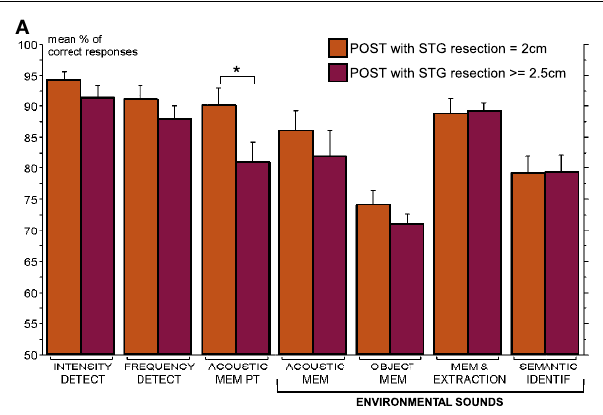
fractionated into two sub-groups according to the postoperative delay: POST patients tested after a short delay between 3 and 4 months (orange, n = 9) and POST patients tested after a long delay superior to 2 years (brown, n = 11). No signifi cant difference (Mann–Whitney tests) has been found between these two groups. DETECT, detection; IDENTIF, identifi cation; MEM, short-term memorization; PT, pure tones; POST, postoperatively tested